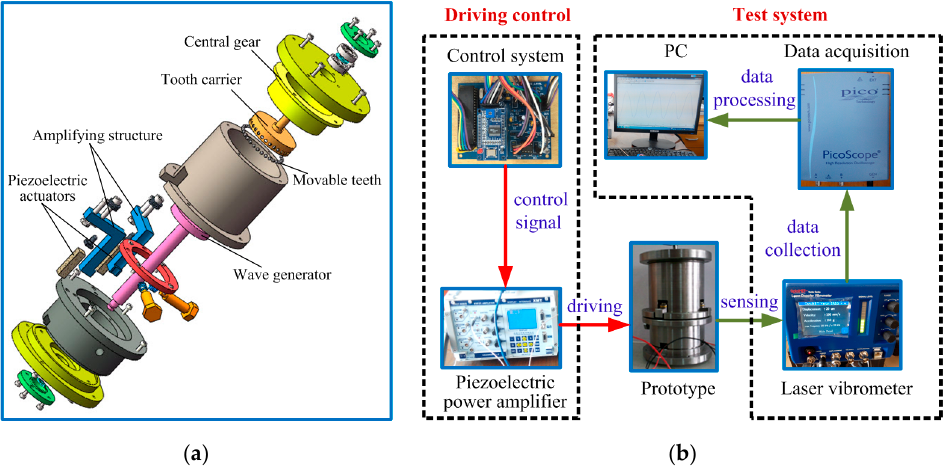
Figure 23. Principium experiment of the piezo-driven focusing mechanism. ( a ) Exploded view of the principium prototype; ( b ) test scheme. Table 2. The prototype rotational speed with di ff erent driving voltages (r /